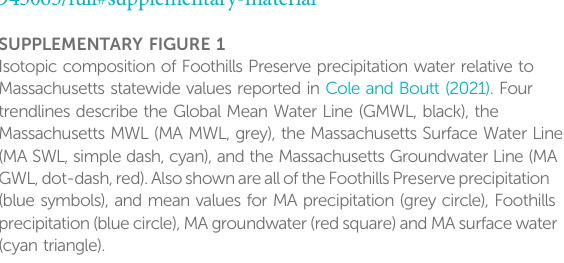
SUPPLEMENTARY FIGURE 1 Isotopic composition of Foothills Preserve precipitation water relative to Massachusetts statewide values reported in Cole and Boutt (2021). Four trendlines describe the Global Mean Water Line (GMWL, black), the Massachusetts MWL (MA MWL, grey), the Massachusetts Surface Water Line (MA SWL, simple dash, cyan), and the Massachusetts Groundwater Line (MA GWL,dot-dash,red).AlsoshownarealloftheFoothillsPreserveprecipitation (blue symbols), and mean values for MA precipitation (grey circle), Foothills precipitation(bluecircle),MAgroundwater(redsquare)andMAsurfacewater (cyan